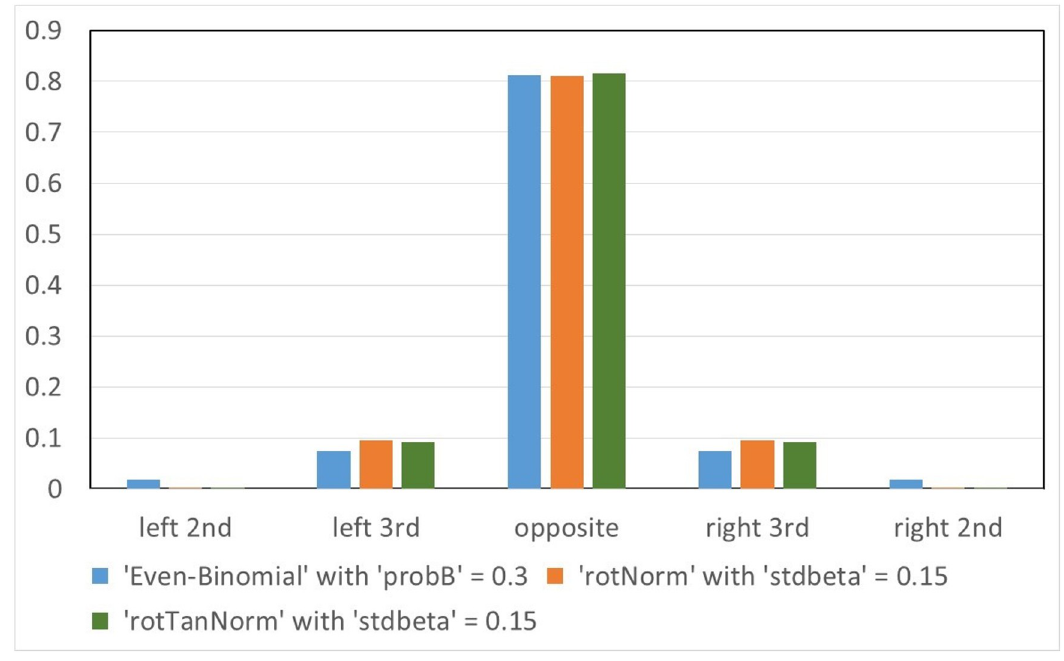
Fig 4. Sample probability distributions of the choice of side2 for ‘Choice2’ options ‘Even-Binomial’ , ‘rotNorm’ and ‘rotTanNorm’ . Relevant parameters (for an 8-sided cell): ‘probB’ = 0.3 for ‘Even-Binomial’ , ‘stdbeta’ = 0.15 for ‘rotNorm’ , and ‘stdbeta’ = 0.15 for ‘rotTanNorm’ .